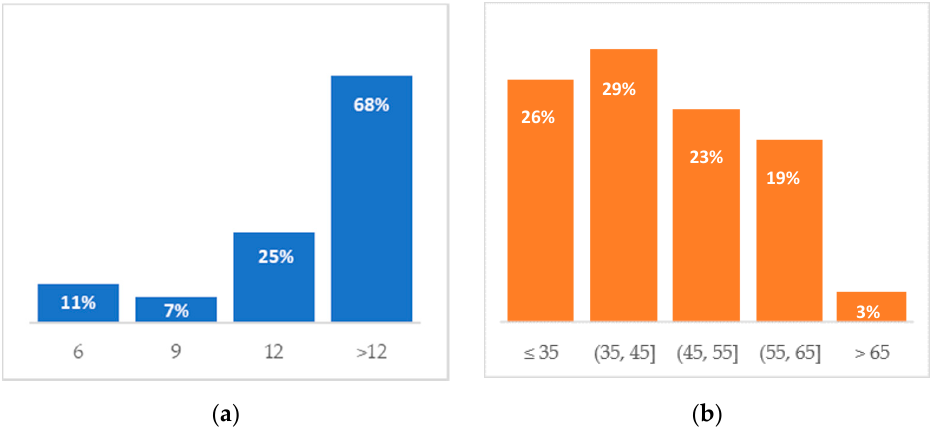
Figure 4. ( a ) Age and ( b ) level of education (in terms of number of years in education) distribution for the aloe vera farmers in the sample (source: own elaboration).